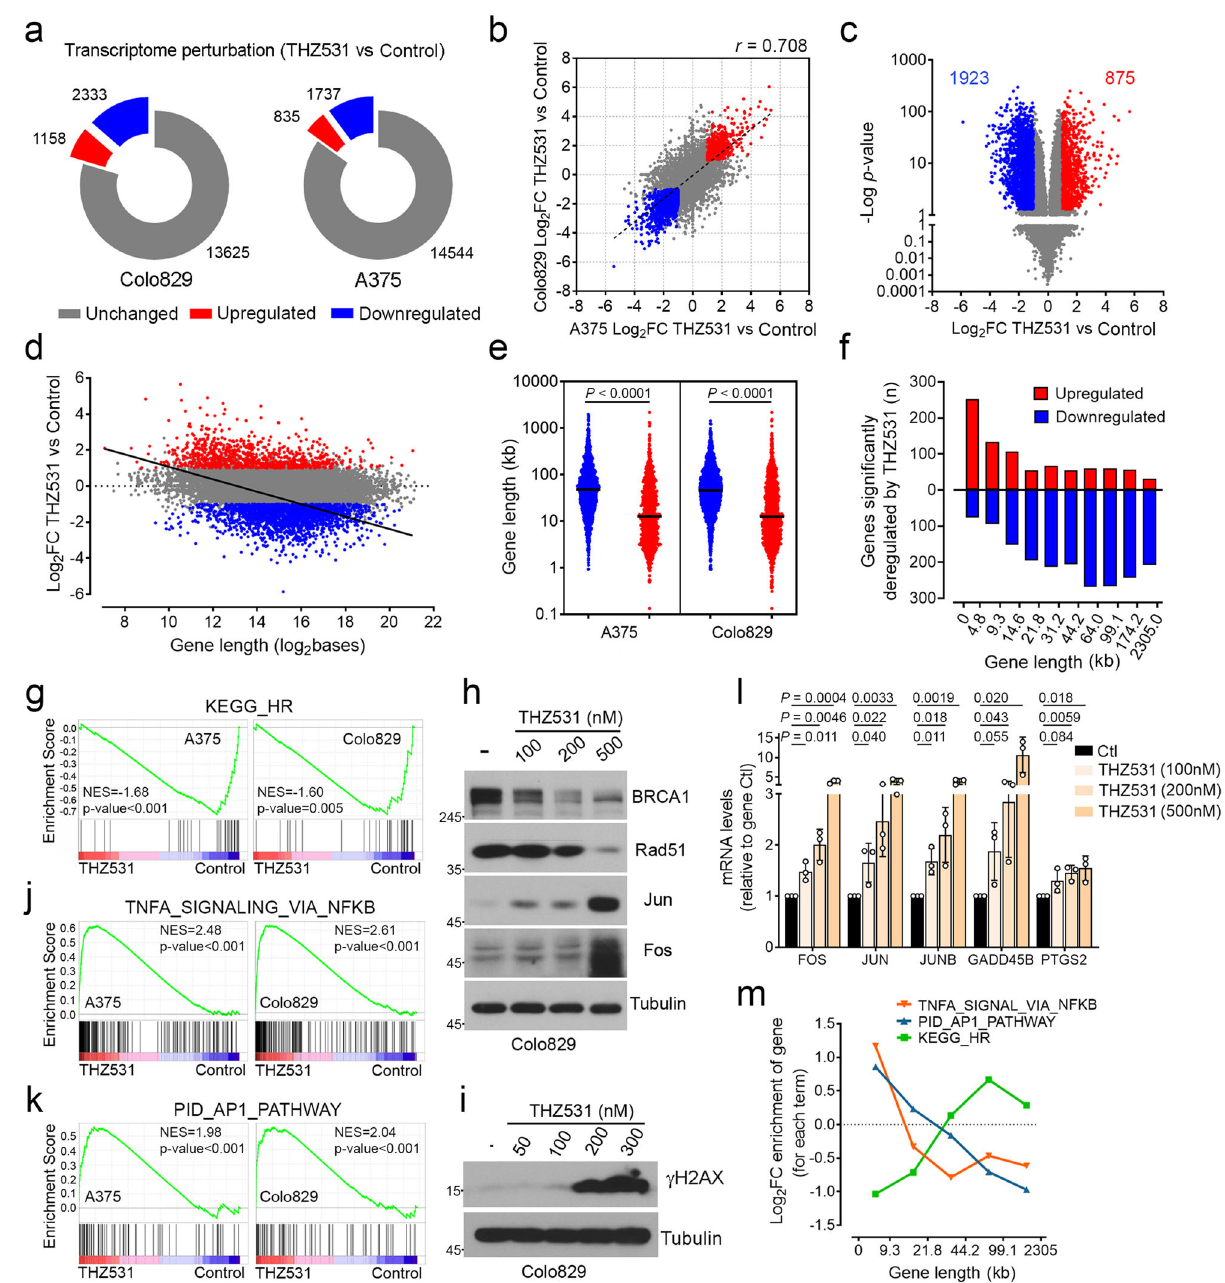
Fig. 4 | CDK12 inhibition increasesthe expression ofgrowth-promoting genes. a GlobaltranscriptomechangesassociatedwithTHZ531(500nM)treatmentfor6h in Colo829 (left) and A375 (right) cells. b Correlation between THZ531-induced gene expression changes in Colo829 and A375 cells. Displayed r =0.703 value was determined using Pearson correlation. c Global THZ531-induced transcriptome changes (Colo829 and A375). d Correlation between THZ531-induced tran- scriptome changes in cells (A375 and Colo829) and gene length. Linear regression for signi fi cant perturbed genes is displayed (Slope − 0.3297, p -value <0.0001). e Gene length of signi fi cant up- and downregulated genes by THZ531 treatment (A375, Colo829). f Number of genes up- or downregulated relative to gene length. The genome was ranked from smaller to longer genes and fractioned into 10 groups containing the same number of genes. g GSEA analysis revealed that the KEGG_HOMOLOGOUS_RECOMBINATION gene set is decreased in both THZ531- treated cells. Immunoblot of Colo829 cells treated for 12h ( h ) or 24h ( i ) with increasing concentrations of THZ531. j , k GSEA analysis revealed that the